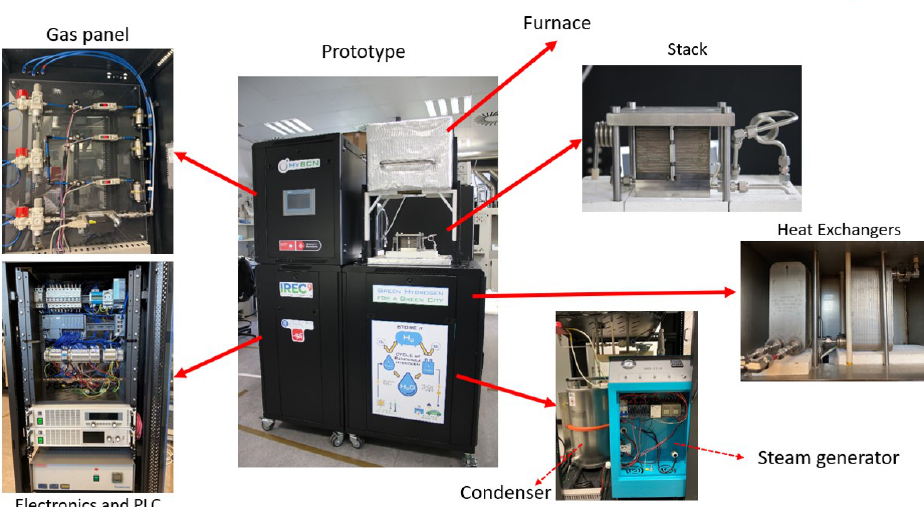
Figure 1. Reversible solid oxide stack and the BoP agents implemented at IREC laboratory.